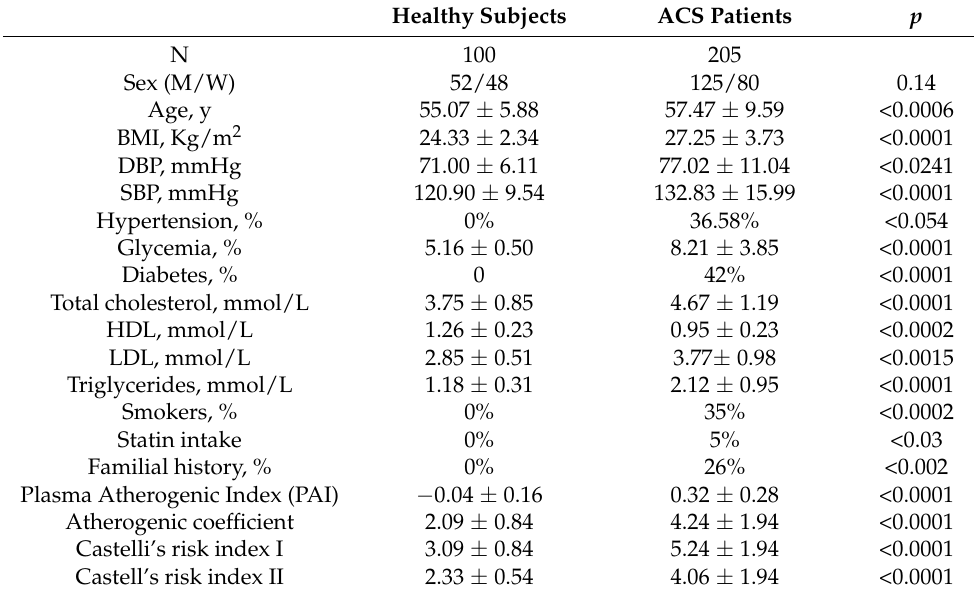
Table 1. Baseline characteristic of acute coronary syndrome patients and control healthy